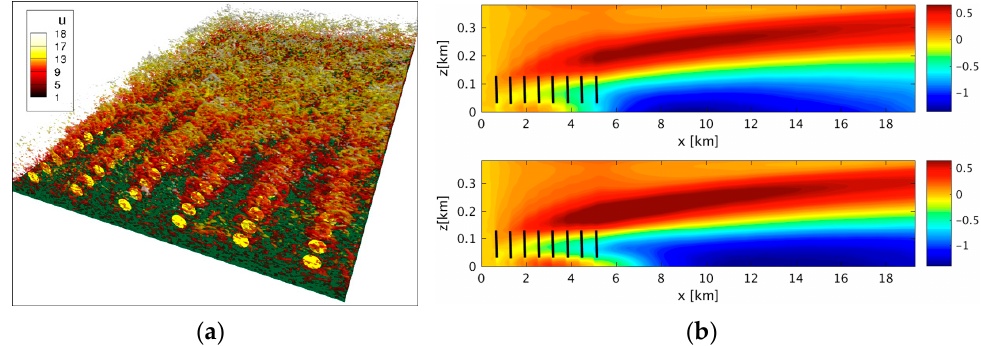
Figure 5. ( a ) Iso-surfaces of Q criterion colored by the streamwise velocity component for a 6 × 7 wind farm; ( b ) contours of mean RH variation in the shadow region (reprinted with permission from [52]).